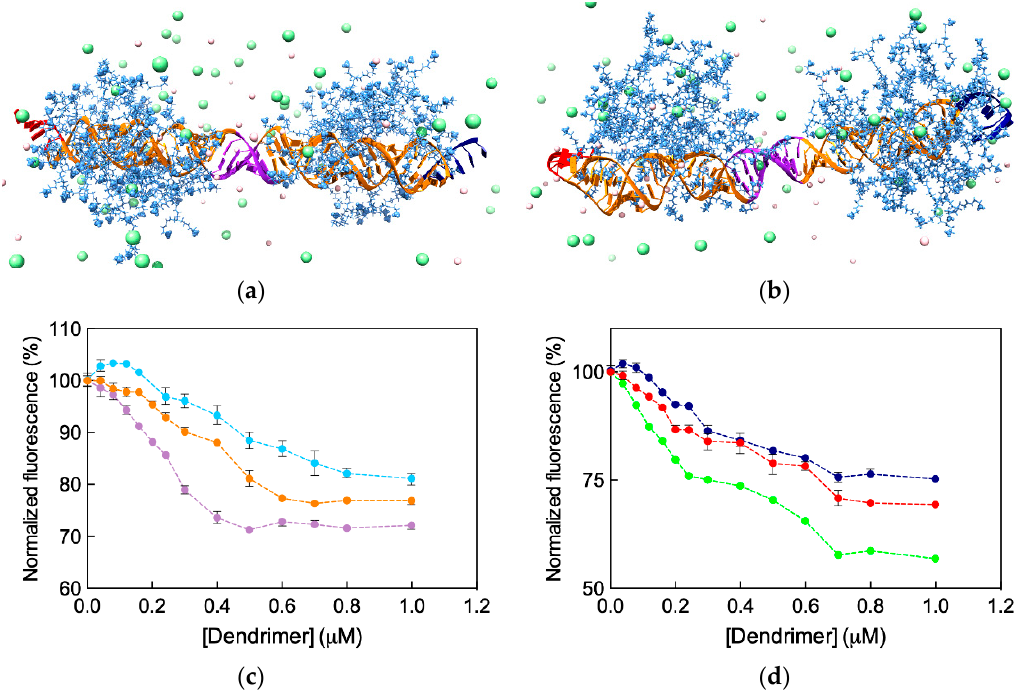
Figure 13. Equilibrated MD snapshots of the (A 5 /T 5 ) 2 ( a ) and (A 7 /T 7 ) 2 ( b ) dimeric ssiRNAs in complex with the G 5 TEA-core dendrimer pH 7.4 and in the presence of 0.15 M NaCl. Molecule representations and color scheme as in Figure 12. The double-stranded portion of the concatenated (hybridized) ssiRNAs is highlighted in purple. ( c ) and ( d ) Experimental binding of ssiRNAs bearing complementary and non-complementary overhangs with the G5 TEA-core dendrimer by ethidium bromide (EB) displacement assay. Color legend: ( c ) Light blue, T 5 / T 5 ssiRNA; orange, A 5 / A 5 ssiRNA; light purple, A 5 / T 5 ssiRNA; dark blue; ( d ) T 7 / T 7 ssiRNA; red, A 7 / A 7 ssiRNA; light green, A 7 / T 7 ssiRNA. Adapted from [57], with permission of the American Chemical Society.